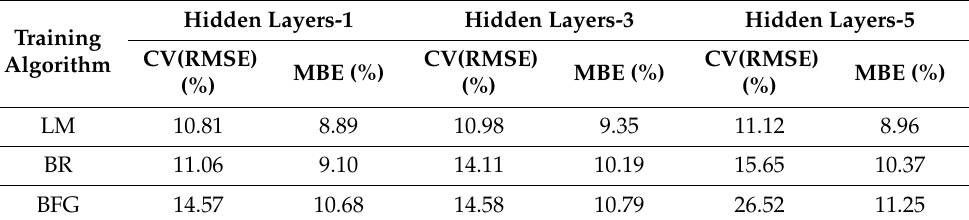
Table 5. CV(RMSE) and MBE of VOCs concentration prediction result.